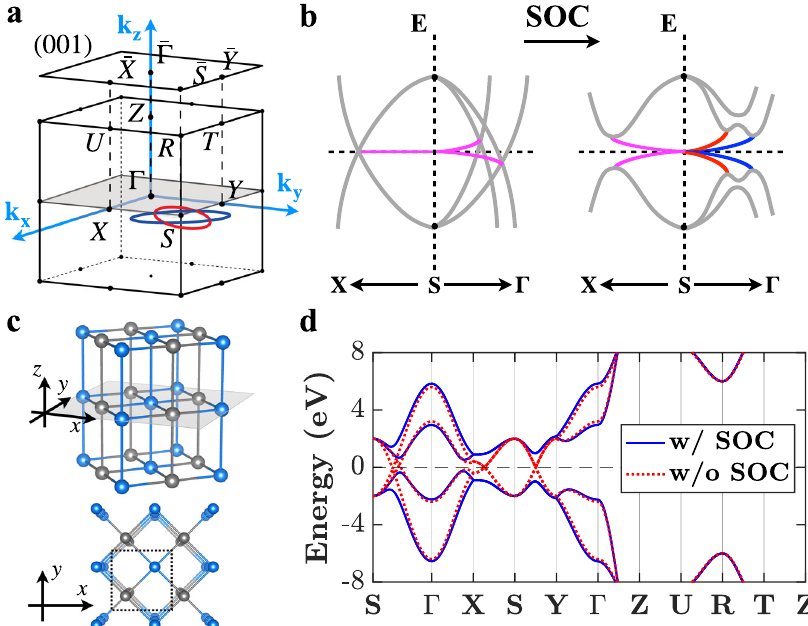
Fig. 1 Phase transition from a NLSM to a TCI, crystal structure, and band structures. a Brillouin zone (BZ) of bulk and the projected (001) surface in SG Pbam (No. 55), with the high-symmetry points. The CICE nodal lines are on the xy -plane centered at S point. b Schematic band structures demonstrating the SOC-driven transition from a NLSM exhibiting the CICE NLs 37 (left panel) to a TCI (right panel). Gray denotes the bulk states, and the magenta, red and blue indicate the (001) surface states, i.e., the interwined DSSs of the NLSM (left panel), and the TSSs of the TCI with two intertwined Dirac cones (right panel). c Orthorhombic crystal structure of the lattice model in Eqs. (1) and (2), consisting of a lattice with two sublattices A (in blue) and B (in gray). d Band structure of the model with and without SOC,